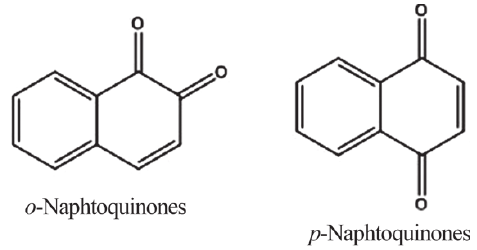
Figure 1 - Isomeric forms of ortho-and para-quinonone.